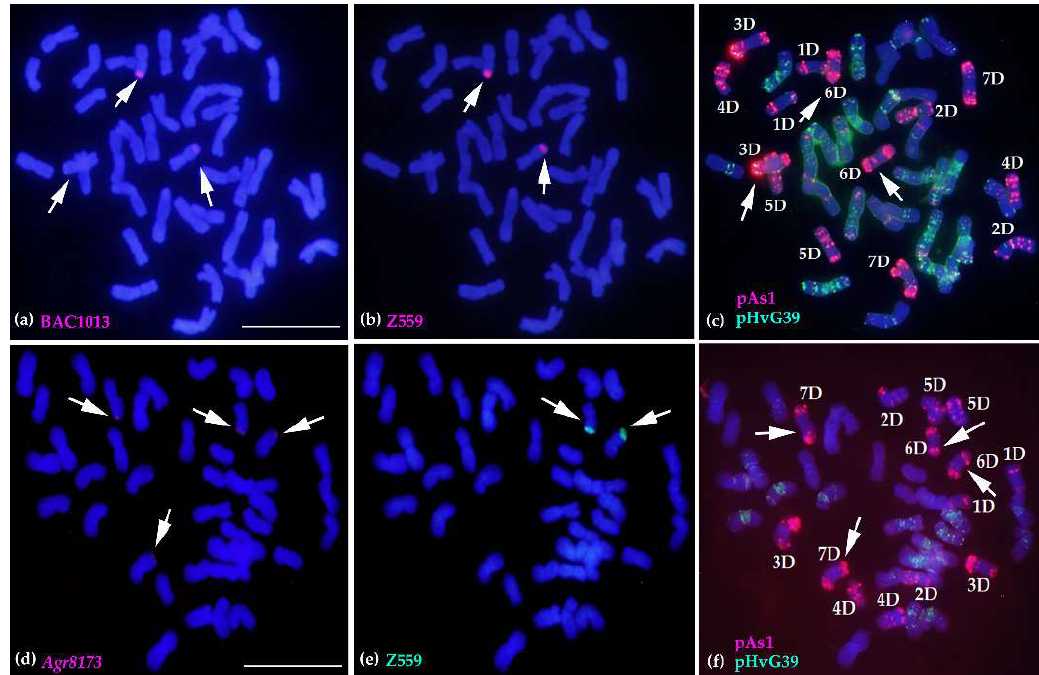
Figure 4. The cytogenetic analysis of the introgression in the translocation line WAT655 using the DNA of A . cristatum BAC clone BAC1013, the gene Agr8173 , A . cristatum “Z559”, pAs1, and pHvG39 as the probes. ( a , d ) The probes BAC1013 (red) and Agr8173 (red) were used for the first round of FISH, respectively. The white arrows indicated the A . cristatum chromatin in the wheat background. ( b , e ) The DNA of A . cristatum “Z559” as the probes (red/green) was used for the second round of GISH on the same slides. The white arrows indicated the A . cristatum chromatin in the wheat background. ( c , f ) The probes pAs1 (red) and pHvG39 (green) were used for the third round of FISH on the same slides. The white arrows indicated the wheat chromosomes that the A . cristatum chromatins were located on. Wheat chromosomes were in blue strained by DAPI. (scale bar = 10 µm).